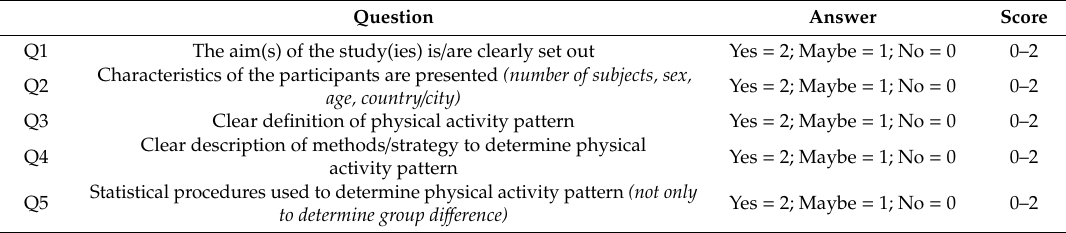
Table 1. Quality criteria developed to analyse the